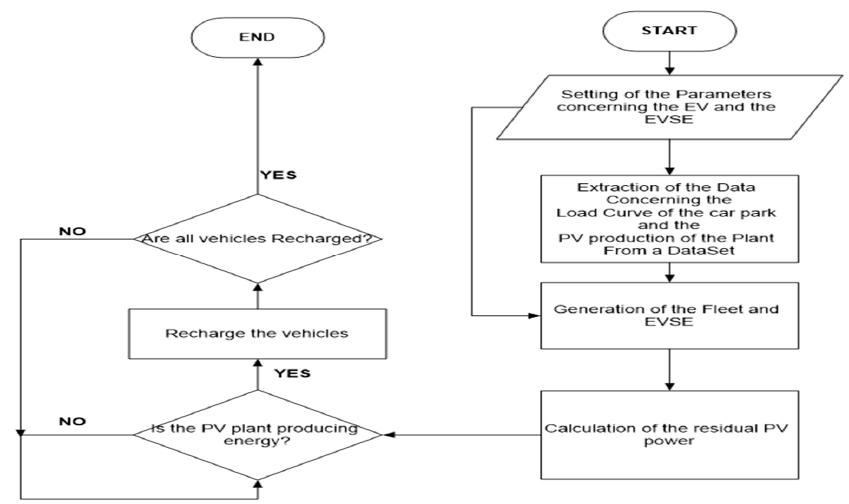
Figure 15. Flowchart of the “green” algorithm.